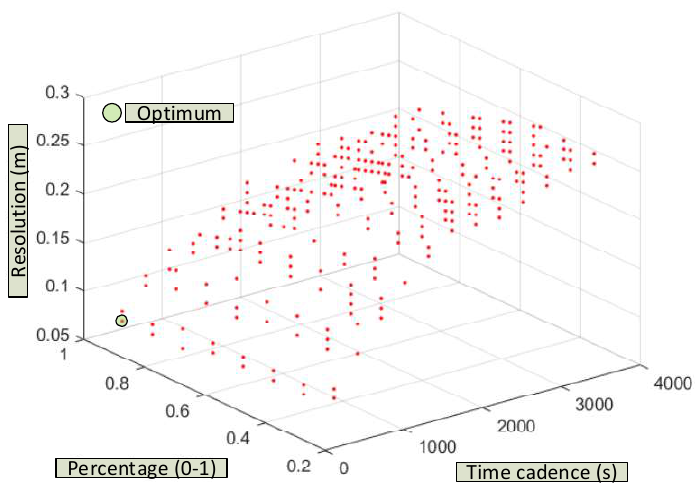
Figure 12. Resolution of the dynamic NARNN as a function of the selected time interval and the percentage of data used for validation.